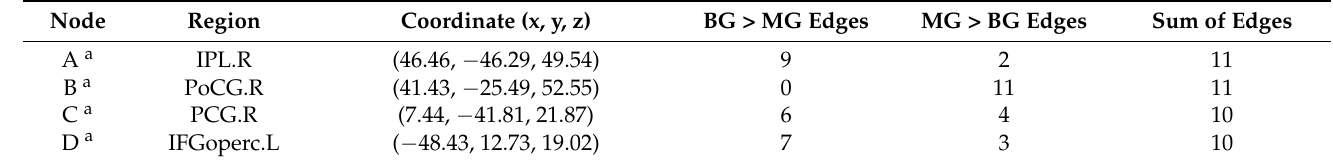
Figure 1. Whole-brain connectivity differences between the two groups. These components were thresholded for visualization to show nodes with a sum of edges differences ≥ 10 with all the nodes to which these suprathreshold nodes were connected. Red lines denote the subnetwork of bilinguals (BG) > monolinguals (MG) at p < 0.0001 after network-based statistics (NBS) correction ( A ). Blue lines denote the subnetwork of bilinguals (BG) < monolinguals (MG) at p < 0.0001 after NBS correction ( B ). Note that all figures are shown in neurological convention (subject’s left is the image’s left), and axial views are top-down. Table 2. Node-Level Analysis of Brain Connectivity Differences between Bilinguals and